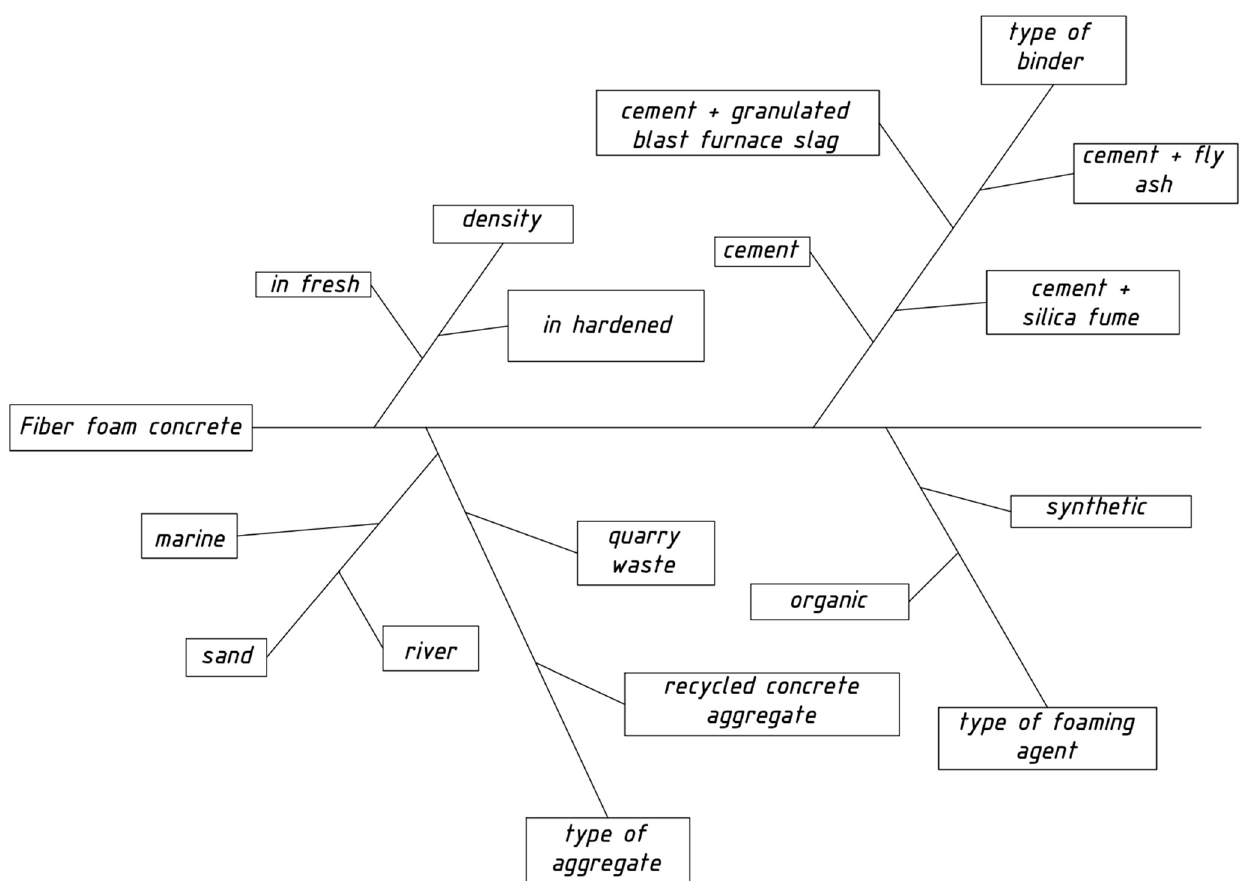
Figure 10. Causal diagram of factors affecting the quality of fiber foam concrete.